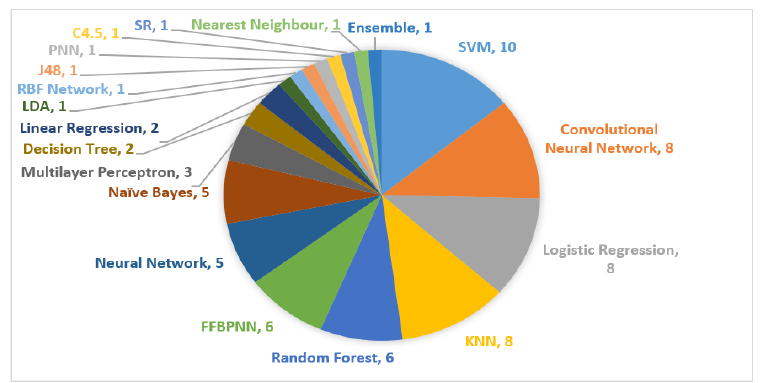
Figure 12. Machine learning technique used in breast cancer detection discussed in this